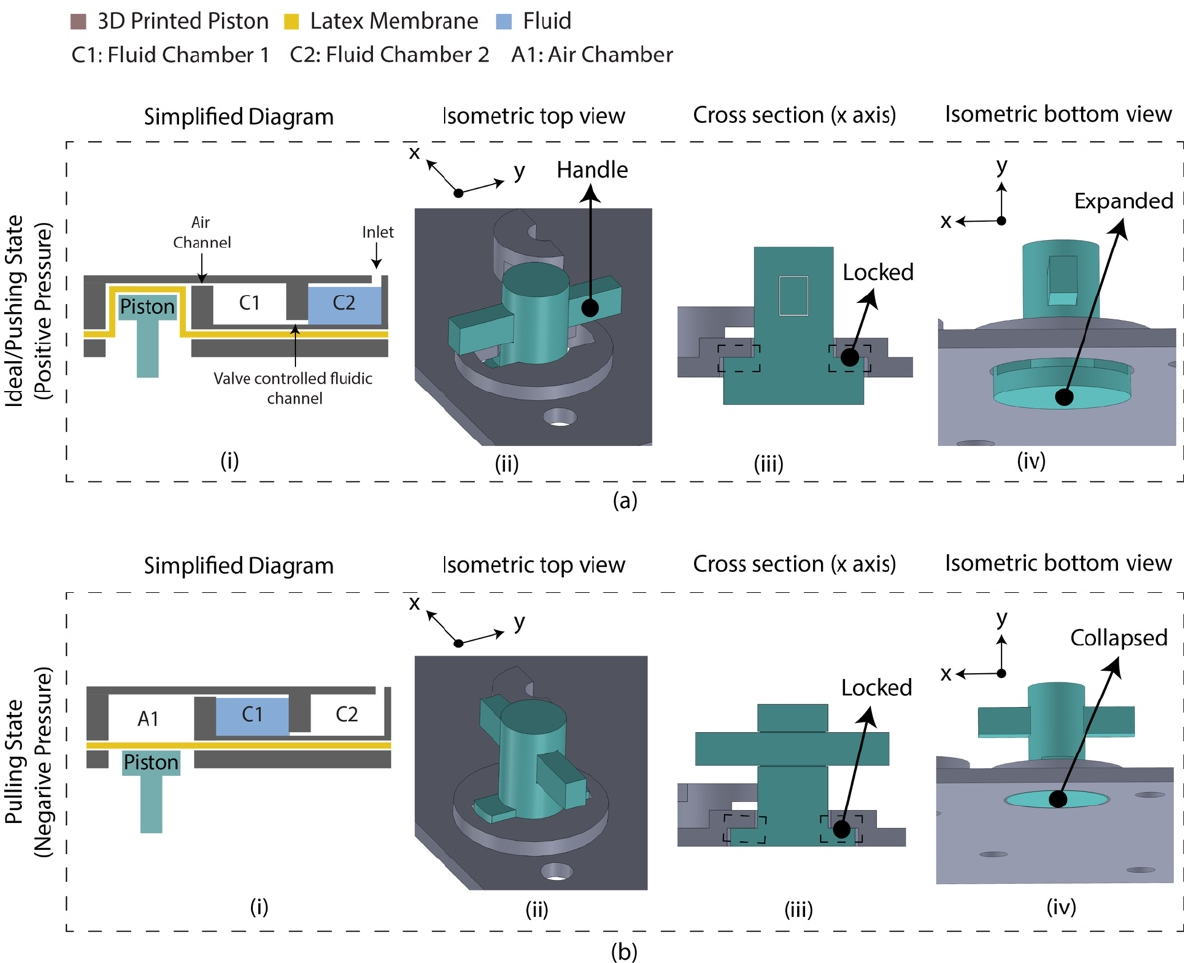
Figure 2. Latex membrane-based micro-pump design in two operating states. ( a ) Ideal/pushing state. The piston requires push action and anticlockwise rotation (90°) to change the state